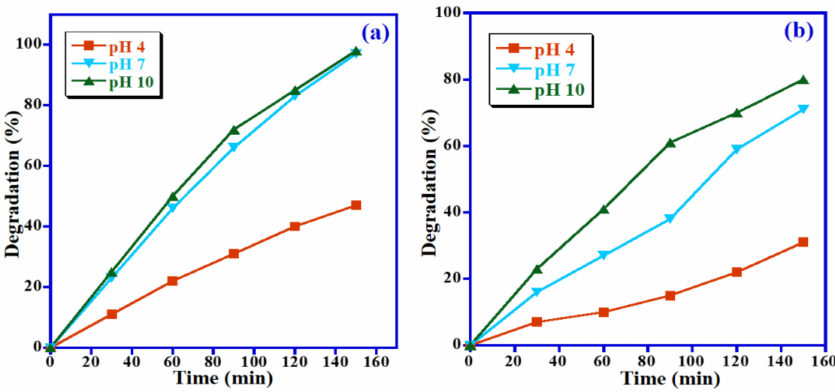
Figure 11. Impact of pH value on the photocatalytic degradation of ( a ) MB and ( b ) MO. Kinetic models of pseudo first-order and pseudo second-order have been studied for photocatalyst Mn 3 O 4 /ZnO/Eu 2 O 3 nanoparticles. Studies revealed that the